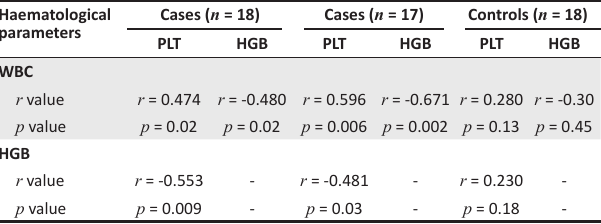
TABLE 2: Correlation between white blood cell count, platelet count and haemoglobin concentration at T in adult sickle cell anaemia patients with 0 (cases) and without (controls) chronic leg ulcers at the University College Hospital and Ring Road State Hospital, Ibadan, Nigeria, March 2015 – June 2015. Haematological